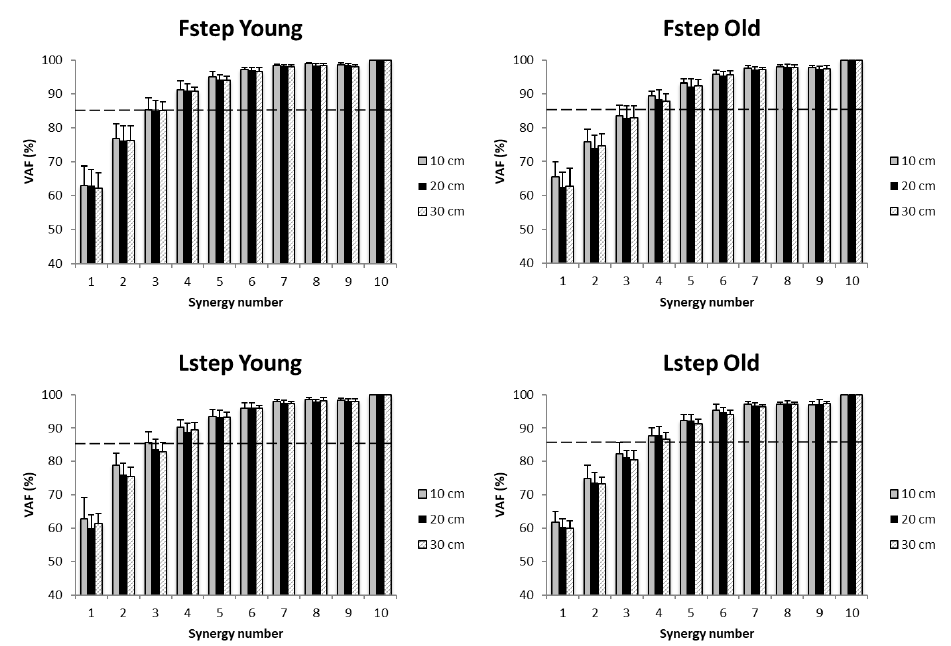
Figure 2. Averaged variance accounted for (VAF) by number of extracted synergies at step heights of 2 10, 20 and 30 cm in forward (Fstep) and lateral (Lstep) stepping directions for young and older women. The appropriate number of synergies was defined as the least number of synergies required to reach > 85% VAF (indicated by dashed lines) and a reconstruction quality of ≥ 75% VAF for each individual muscle.